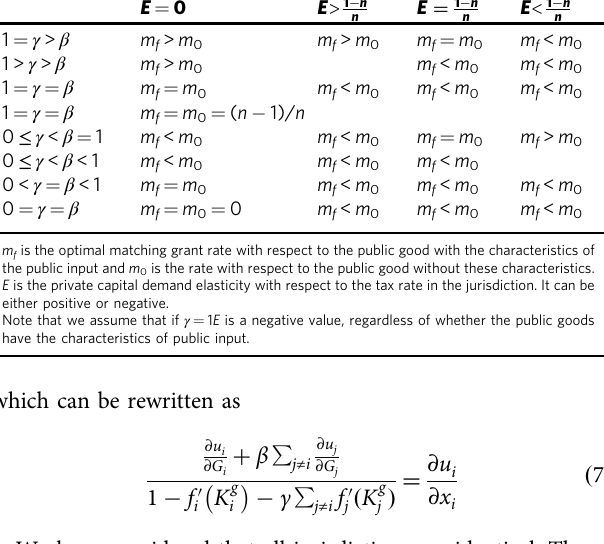
Table 1 The productive effects: the difference of m f and m 0 . Immobile Mobile private private capital